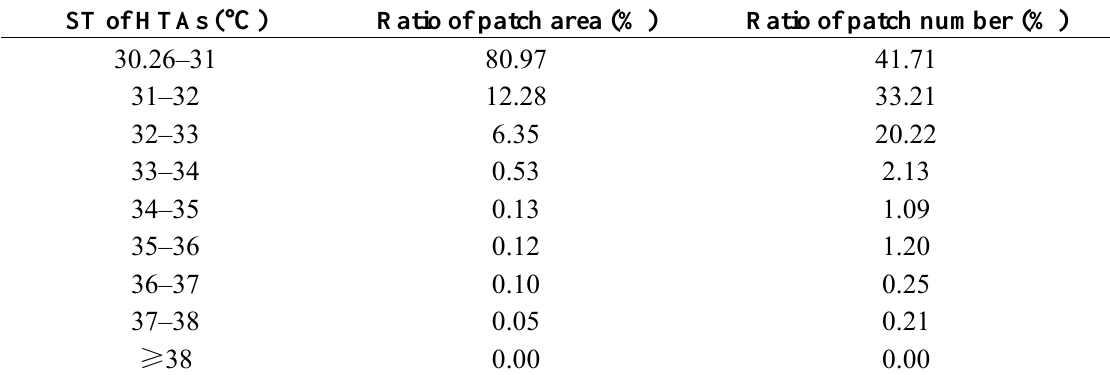
Table 3. The ratio of green patches area and number in the ST of